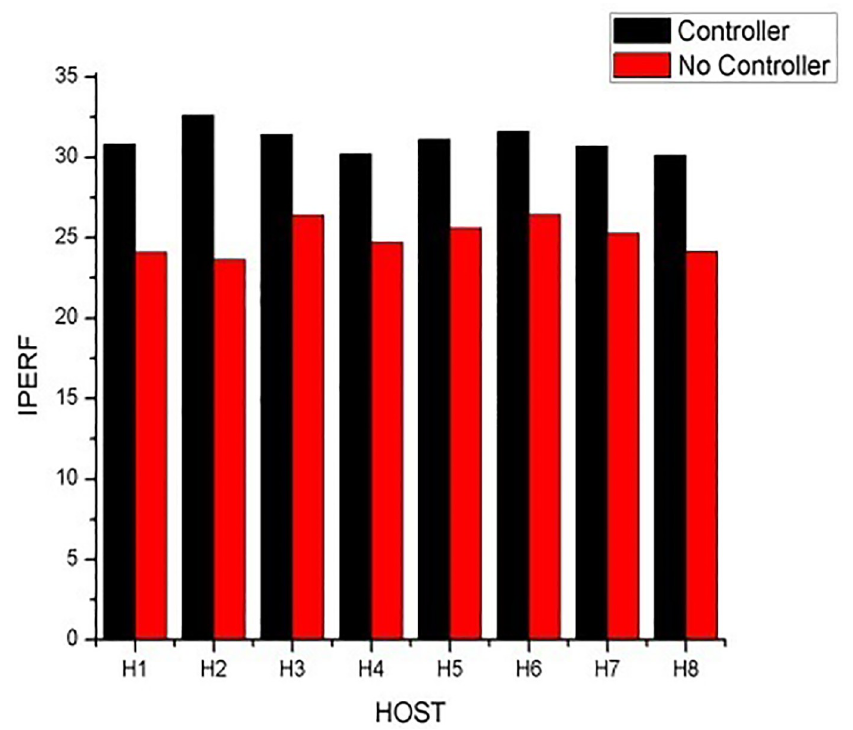
Fig 4. The average results of both networks using